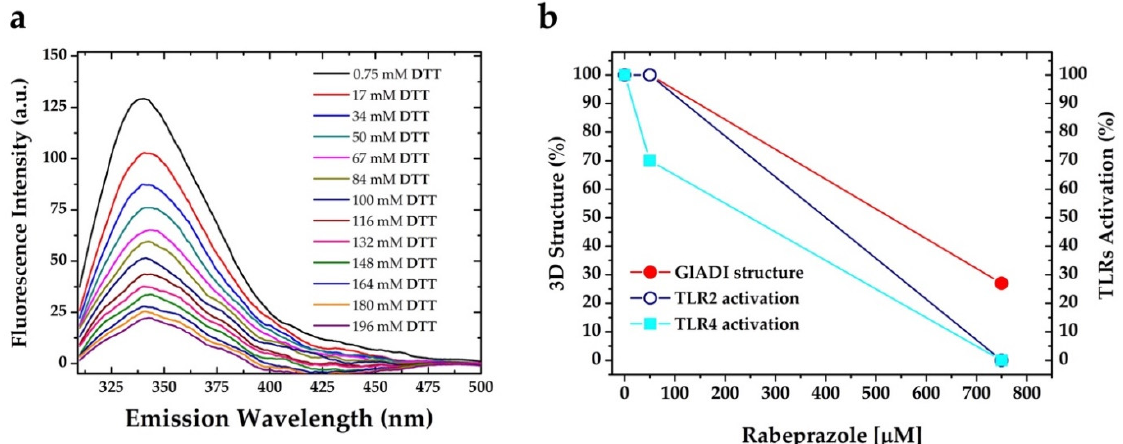
Figure 5. Relationship between 3D structure of GlADI and activation of TLRs. Fluorescence emission spectra of GlADI added with 6 M GndHCl dropped off by increasing concentrations of DTT (disulfide disrupting agent) as a reflection of its denaturing ( a ). The 3D structure stability of GlADI correlates with low concentrations of rabeprazole and activation of TLRs. In contrast, a lack of 3D structure stability correlates with a lack of TLRs activation and high concentrations of rabeprazole ( b